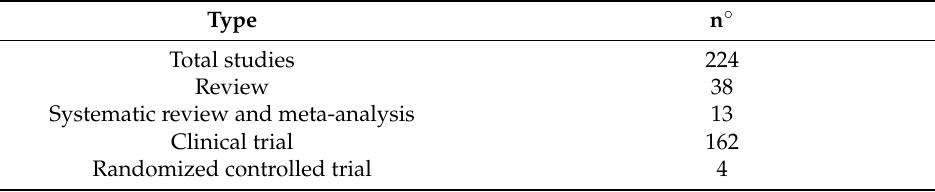
Table 1. List of